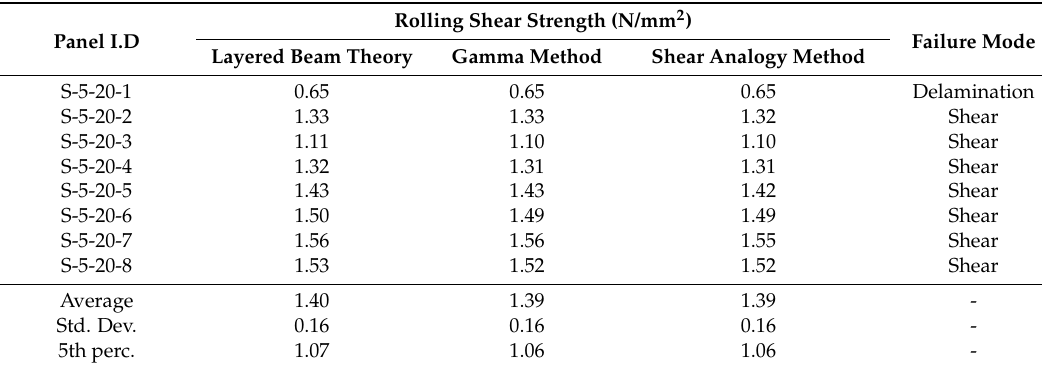
Table 6. Rolling shear test results for five-layer S-5-20 configuration.